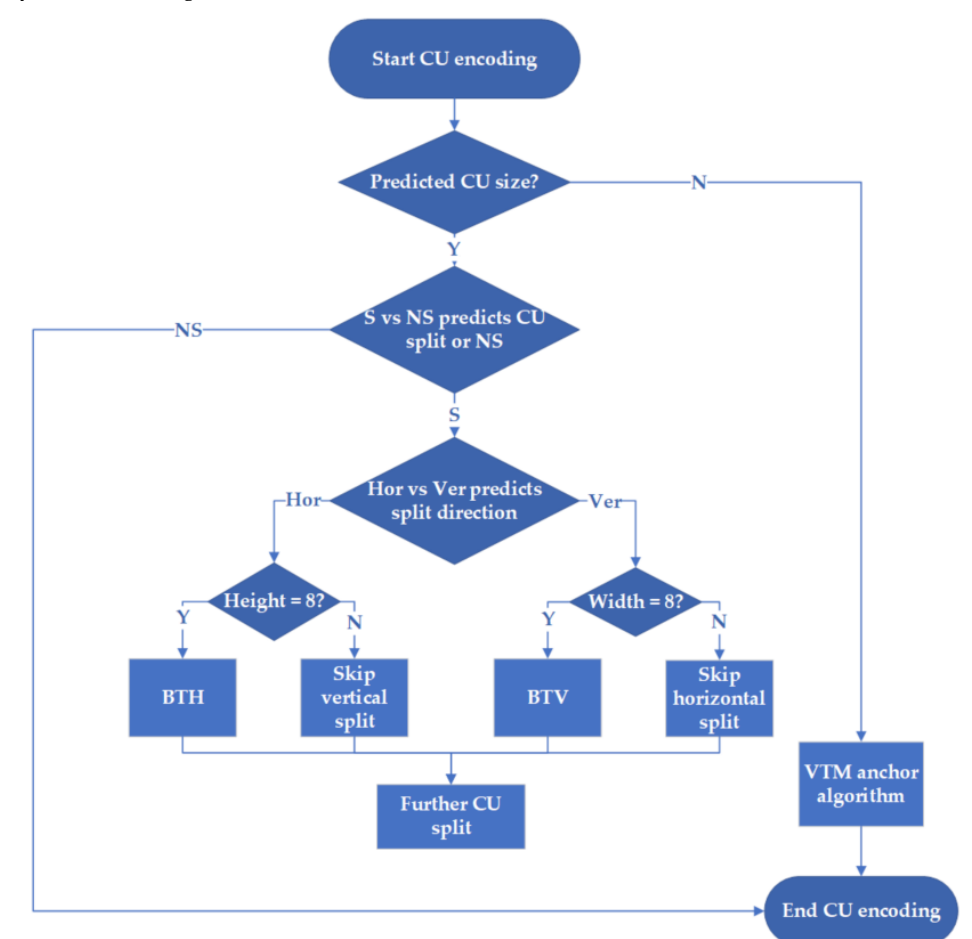
Figure 3. The flowchart of the proposed